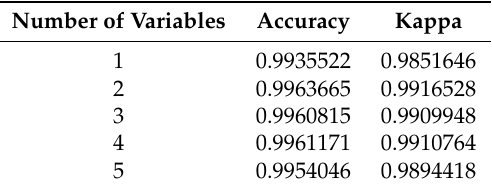
Table 1. Cross-validated performance by considering different numbers of variables regarding the presence model.